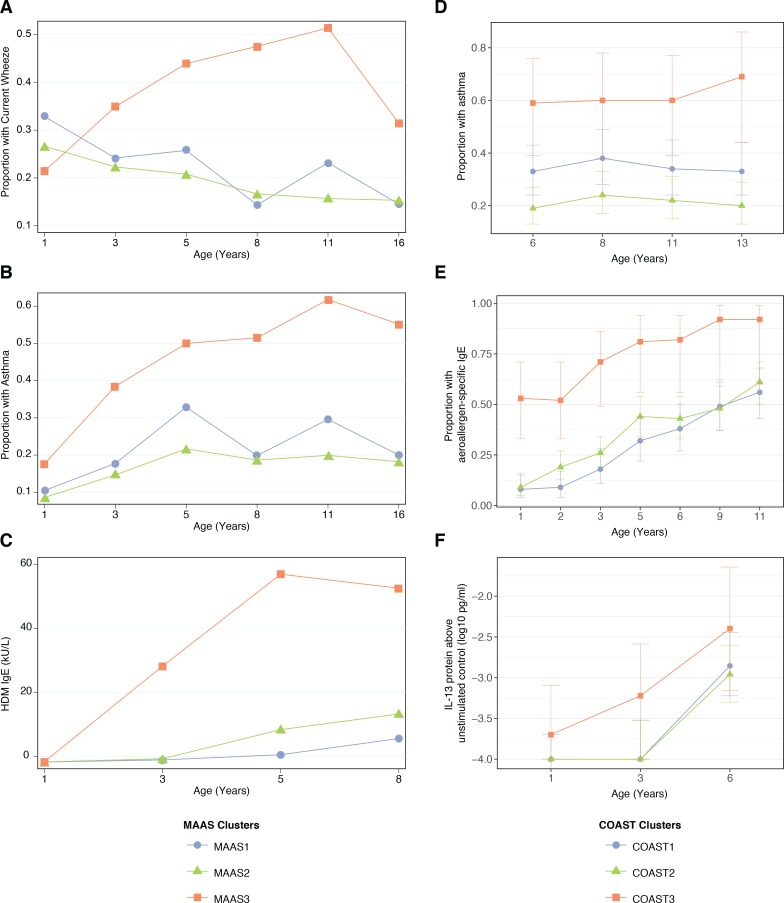
Description of npEM-derived clusters in external cohorts: in MAAS, incidence of wheeze.(A), asthma diagnosis (B), and HDM IgE levels (C); in COAST, incidence of asthma diagnosis (D), proportion of individuals with detectable aeroallergen-specific IgE levels (E), and PBMC protein expression of IL-13 following HDM stimulation above unstimulated control (F) MAAS cohort (N = 934) was classified using npEM model from CAS, into MAAS1 (N = 199, 21%), MAAS2 (N = 692, 74%) and MAAS3 (N = 43, 5%); these correspond to CAS clusters CAS1, 2 and 3, respectively. COAST cohort (N = 285) was similarly classified into COAST1 (N = 105, 37%), COAST2 (N = 151, 53%) and COAST3 (N = 29, 10%).